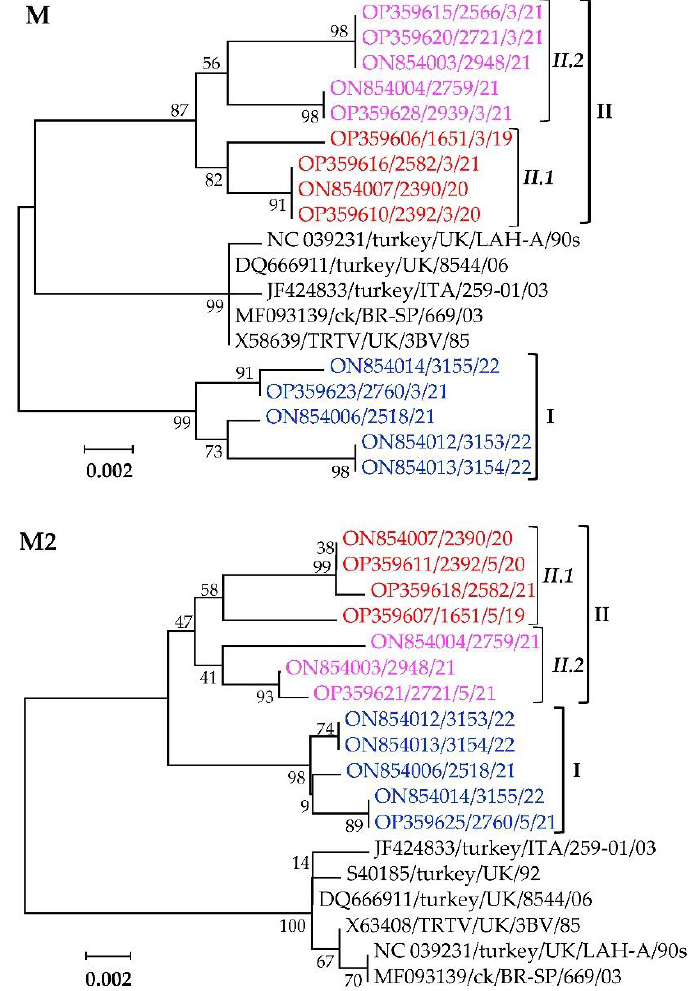
Figure 7. Phylogenetic trees of the matrix (M) and accessory matrix (M2) glycoproteins of the Mexican aMPV-A isolates and aMPV-A strains from the UK and Brazil. Isolate/strain names include GenBank accession number, avian species, country, and year of sample collection.